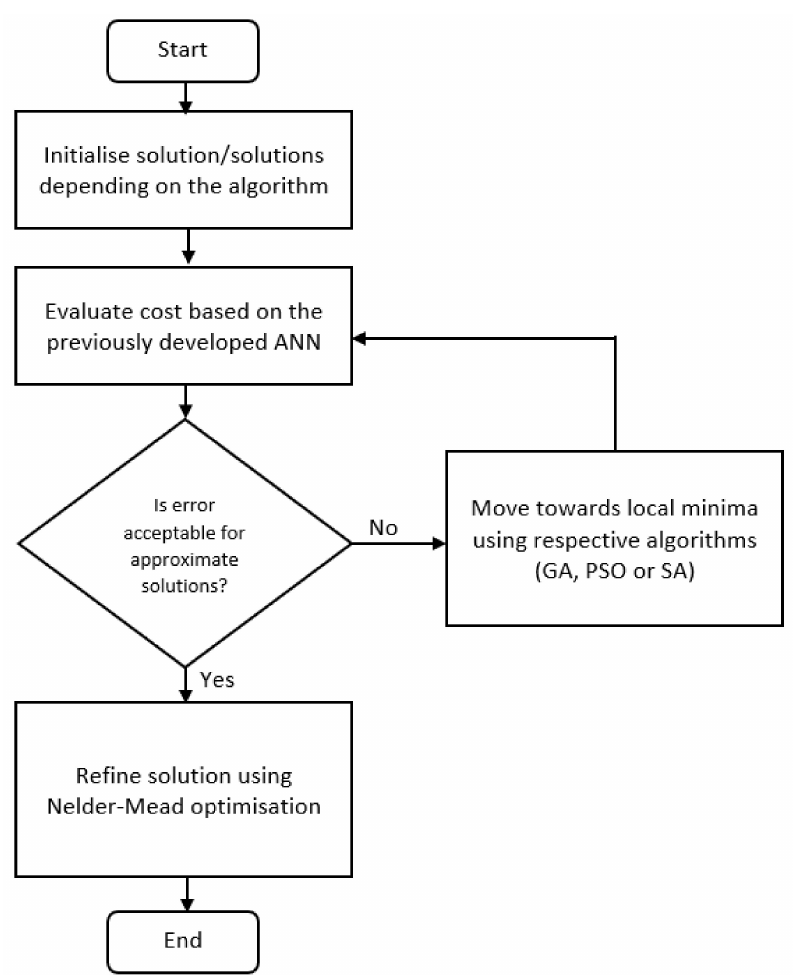
Figure 3. Flowchart of steps followed to optimize welding process using Nelder-Mead optimization